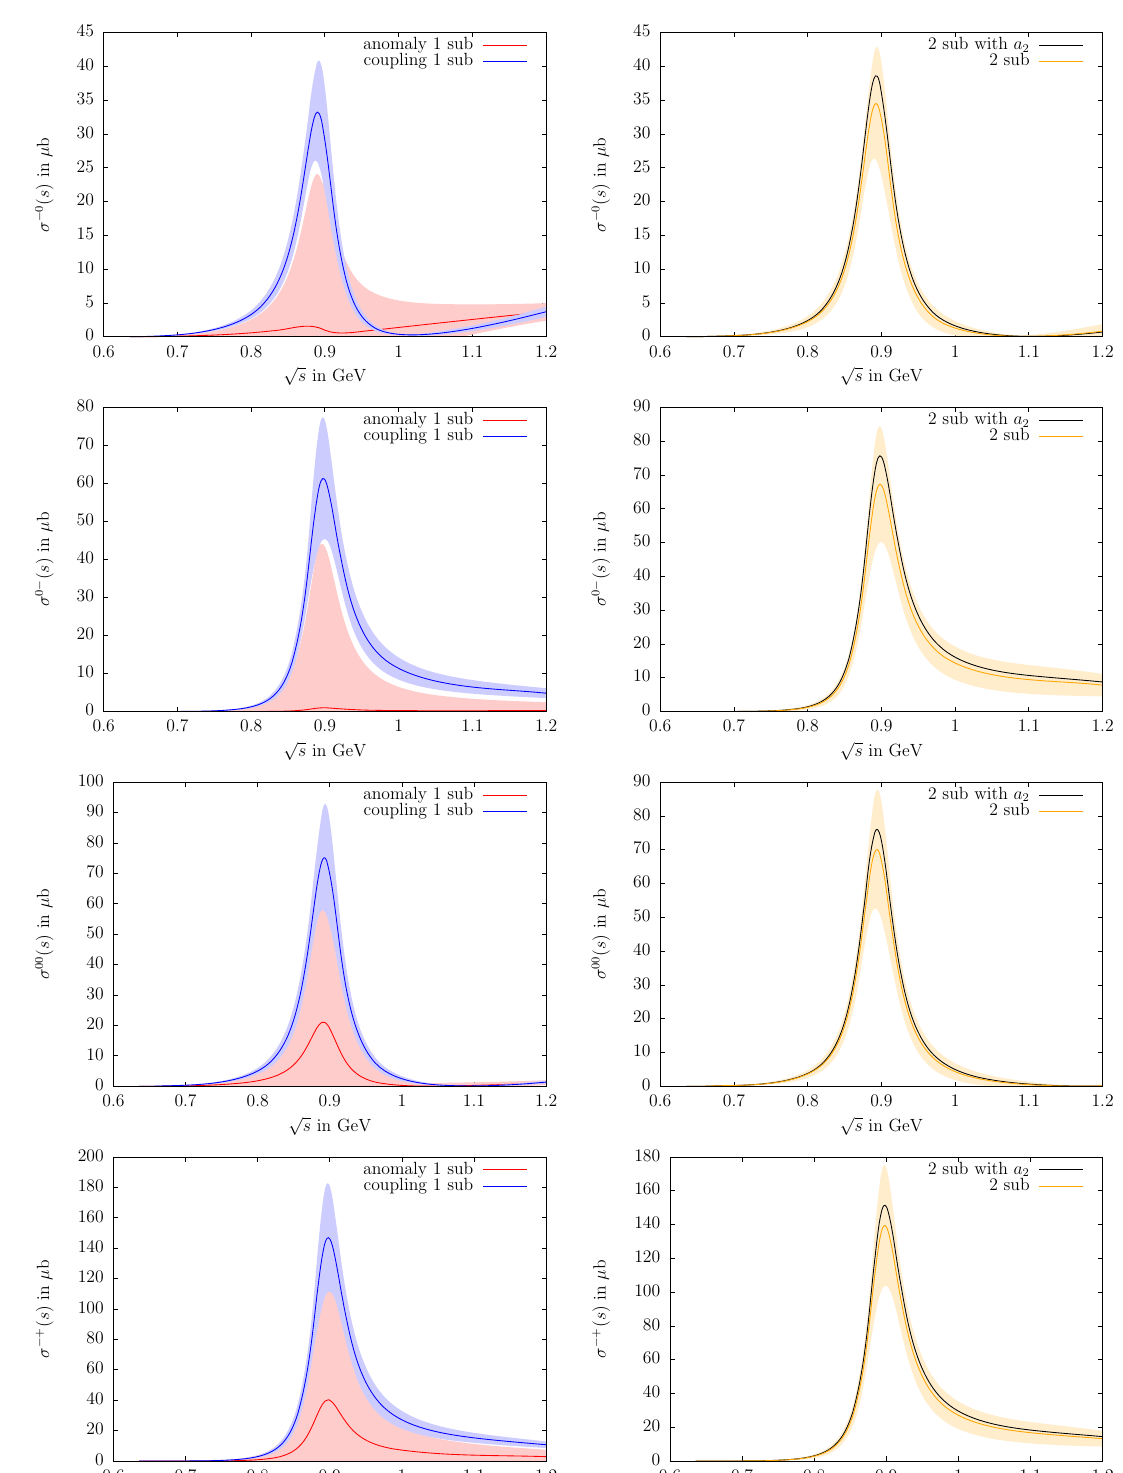
Fig. 8 Cross section results for γ K − → K − π 0 , γ K − → ¯ K 0 π − , γ ¯ K 0 → ¯ K 0 π 0 , and γ ¯ K 0 → K − π + (from top to bottom) including P -wave amplitudes. Left panels: minimal subtraction scheme, matched to the chiral anomaly and the K ∗ radiative couplings separately. Right